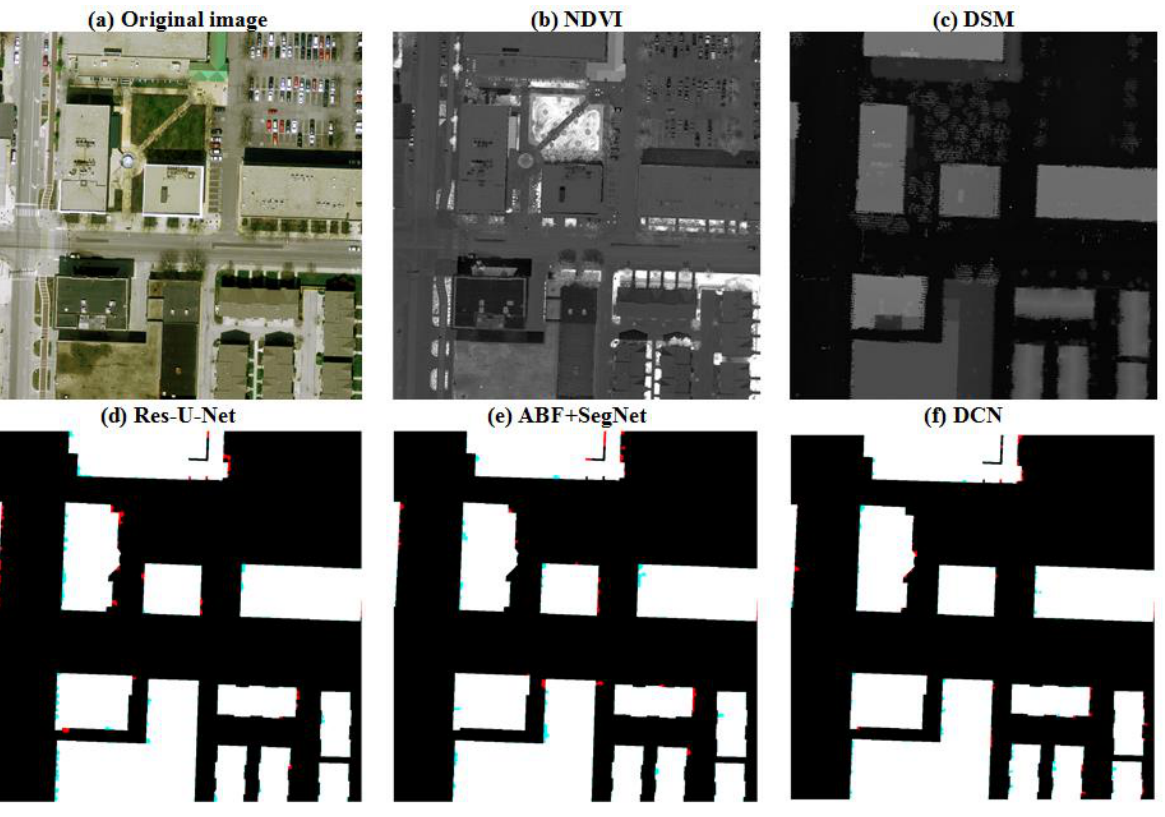
Figure 4. Comparison of BFE results using Res-U-Net, ABF+SegNet and DCN with ground truth in